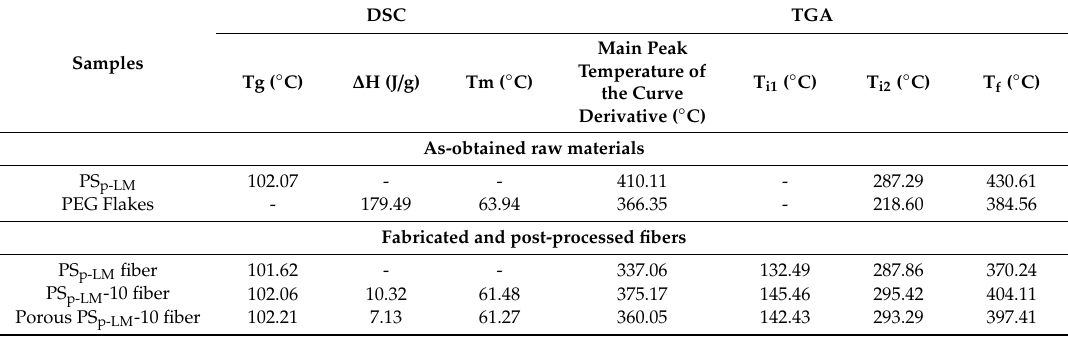
Table 1. Thermal transition temperatures for as-obtained raw materials and fabricated and post-processed fibers using DSC and TGA.